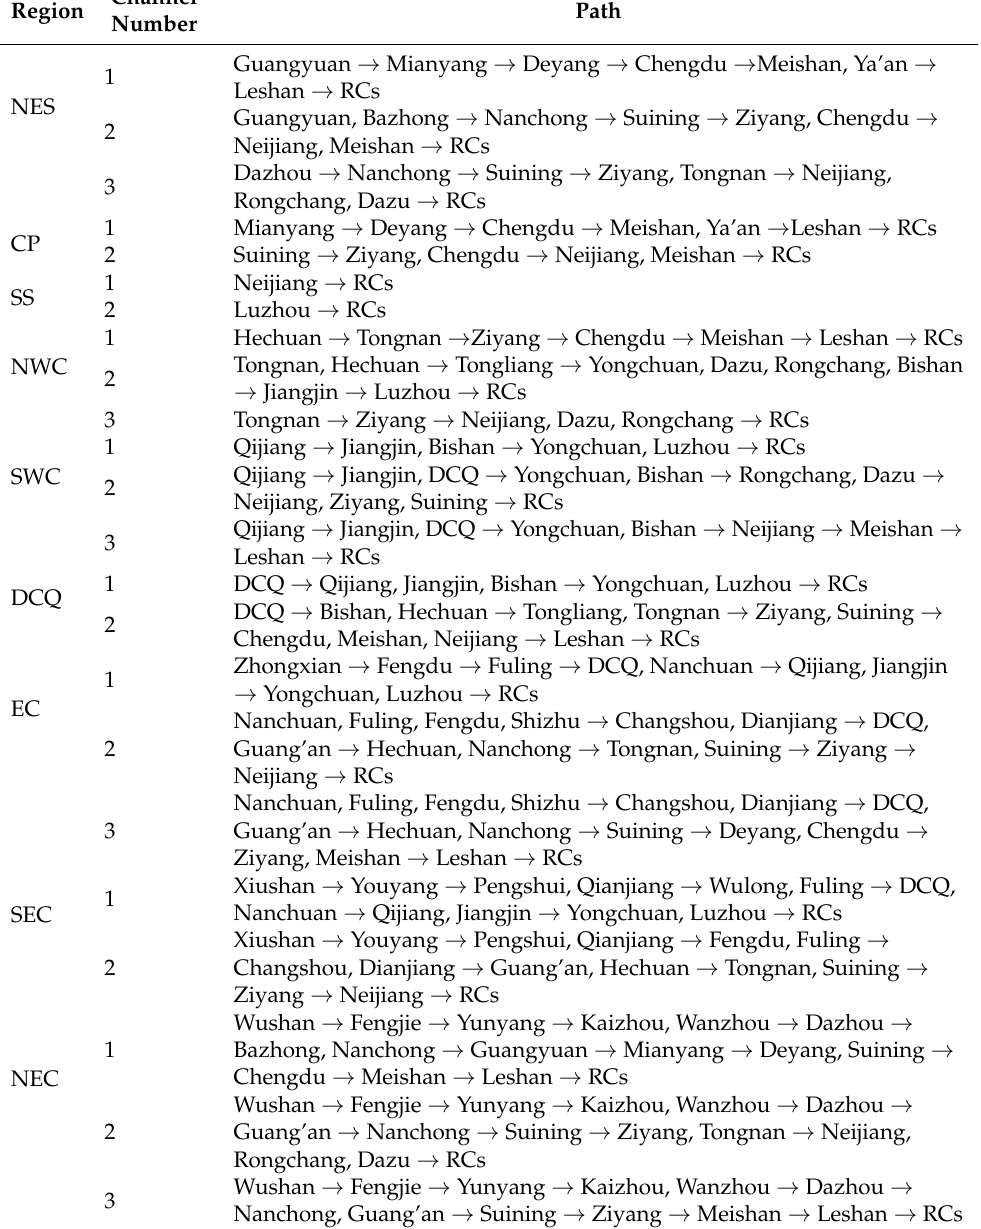
Table 1. Transport channels of tracer particulates affecting the receptor cities originating in different urban agglomerations of